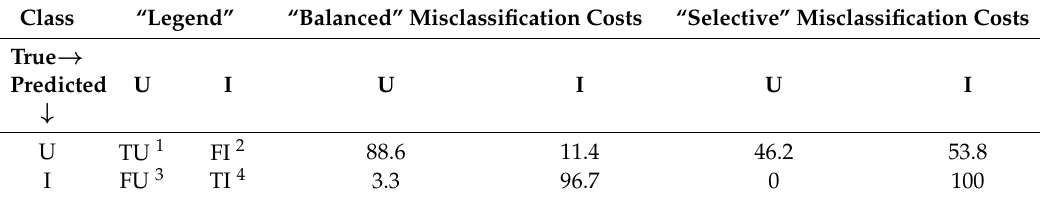
Figure 7. Graphical representation of the pruned tree (FeederLengh in km). Table 3. Confusion matrix for a pruned classification tree with “balanced” (reflecting the data structure) and “unbalanced” (to avoid misclassification I → U